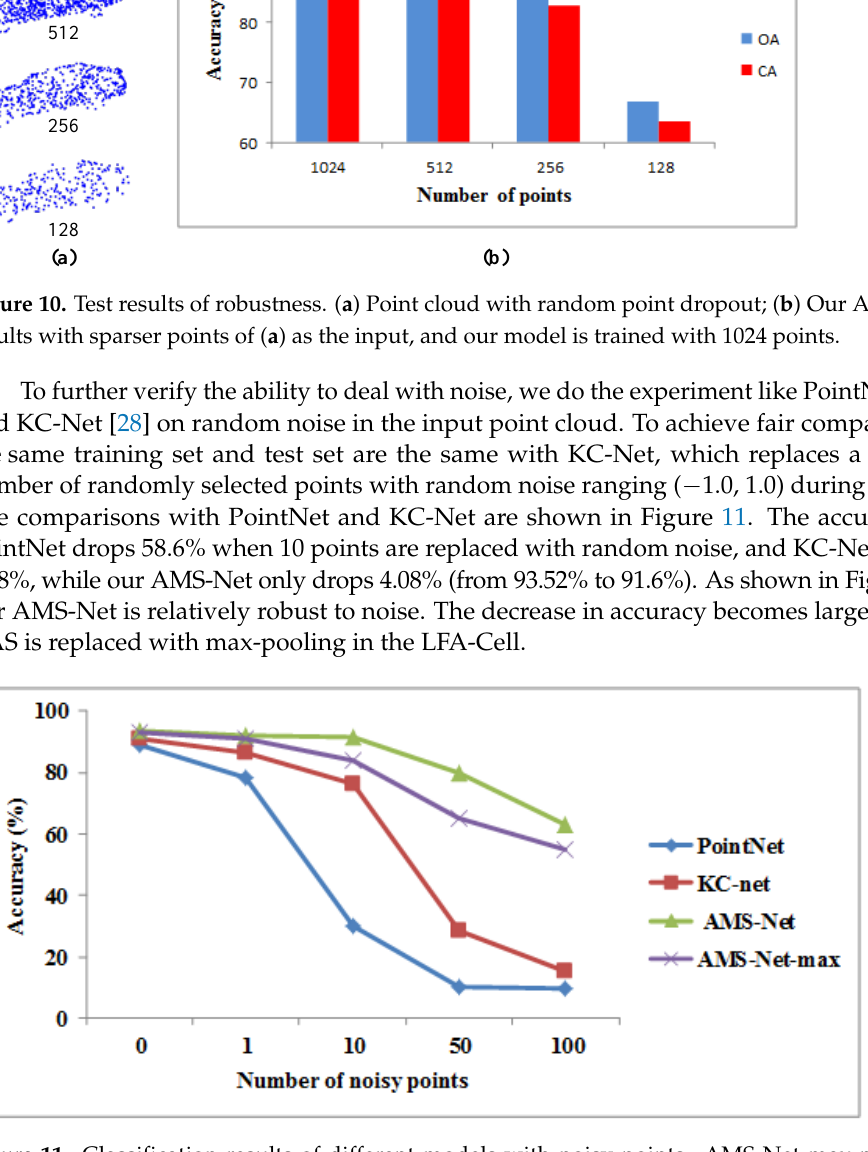
Figure 11. Classification results of different models with noisy points. AMS-Net-max model is replaced the AAS with max-pooling in the LFA-Cell.